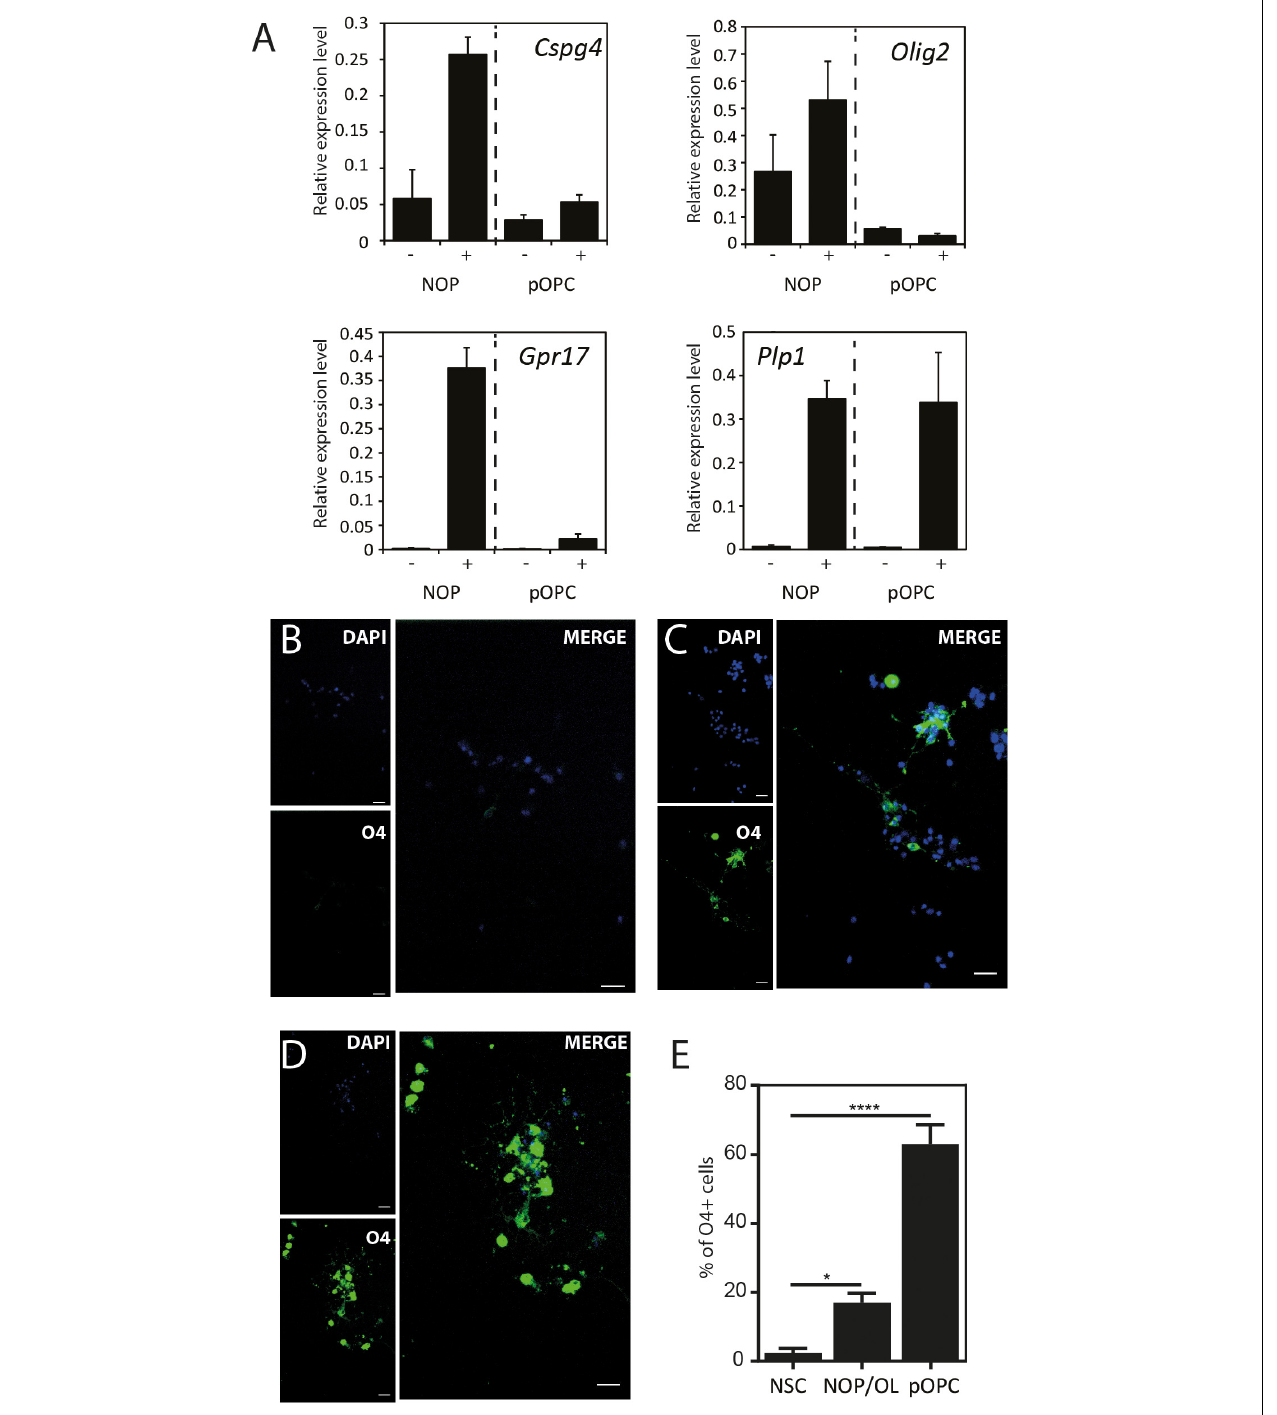
FIGURE 5 | NOP differentiate into OL with a lower efficiency than pOPC. (A) Quantification of OL lineage-related genes after culturing in OL differentiation medium: OPC-marker ( Cspg4 ); OL-lineage-related transcription factor ( Olig2 ); OPC/pre-OL marker ( Gpr17 ); OL marker ( Plp1 ). mRNA were isolated from NOP or pOPC either before or after culturing in OL differentiation medium for 6 days, and relative gene expression analyzed by qPCR. Expression levels of each mRNA were normalized relative to that of GAPDH mRNA. Graphs indicate expression levels from four cell populations: NOP, T3-stimulated NOP (NOP/OL), pOPC, and differentiated pOPC (pOPC/OL). Data are mean ± SD (bars) of three determinations. (B–D) Representative images of immunofluorescent staining for O4 antigen in NSC (B) , NOP (C) , and pOPC (D) after culturing in OL differentiation medium. Nuclei were counterstained with DAPI. Scale bar: 20 µ m. (E) Percentage of O4 antigen positive OL in cultures of NOP and pOPC after culture in OL differentiation medium. Data represent means ± SD (bars) of three determinations. * P < 0.05; **** P < 0.001.